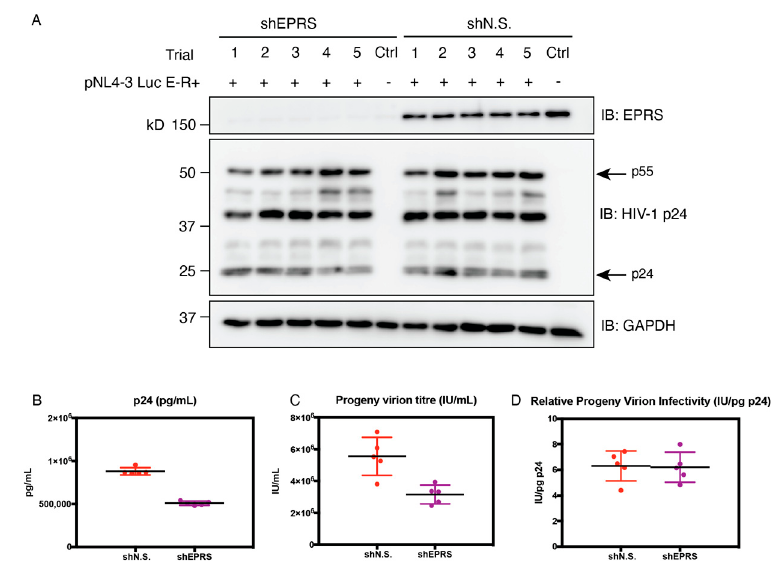
Figure 8. Progeny virion production, titer, and infectivity. HEK293T cells expressing EPRS-targeting or non-silencing shRNA were transfected with pNL4-3 E-R+ and VSV-G-expressing plasmids. ( A ) Immunoblot showing EPRS and Gag expression levels in producer cells. ( B ) p24 level in supernatants, measured by HIV-1 p24 ELISA. ( C ) Viral titer measured by limited dilution in GHOST indicator cells. ( D ) Normalized progeny virion infectivity. Five trials were performed, with the mean value indicated by a horizontal line.